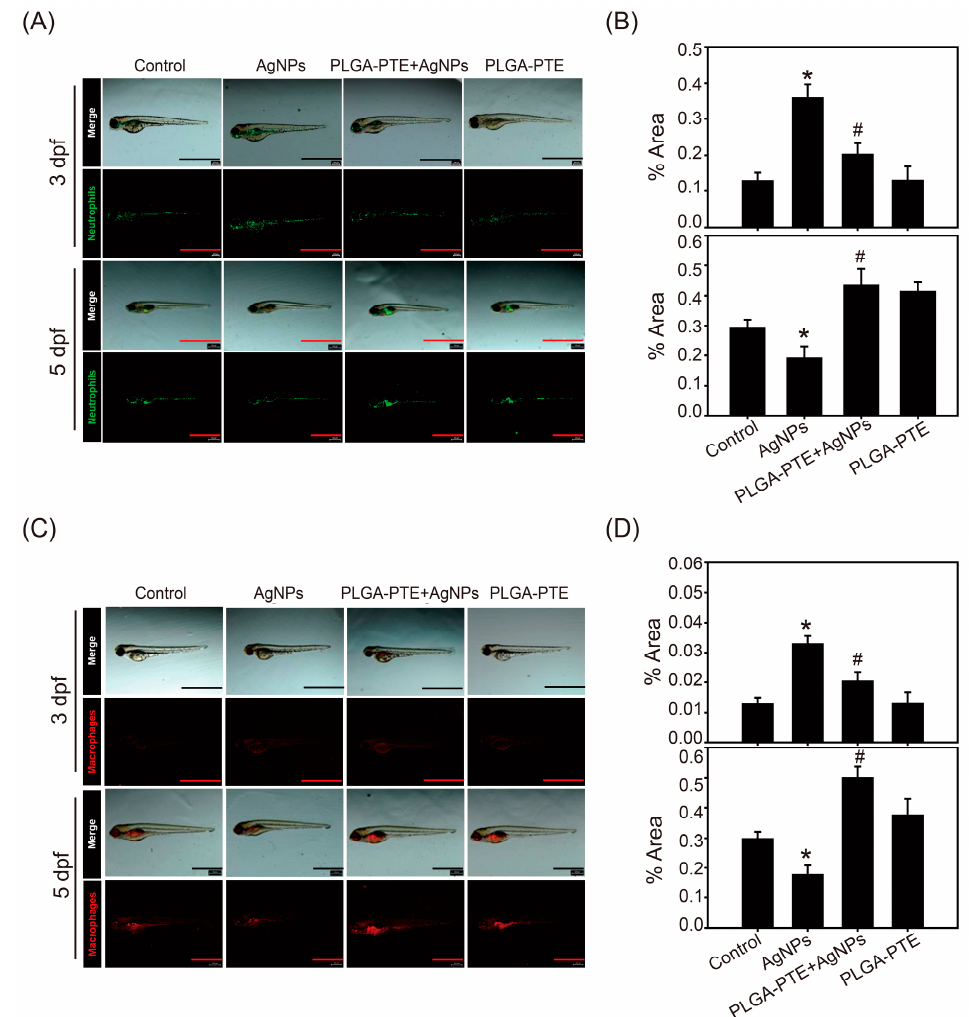
Figure 5. The number and distribution of zebrafish neutrophils and macrophages observed under a stereo fluorescence microscope at 3 dpf and 5 dpf. Zebrafish embryos after exposure to control, 0.3 μ g/mL AgNPs, PLGA-PTE + AgNPs, and 0.3 µ g/mL PLGA-PTE for 3 and 5 dpf. ( A ) The green fluorescence image shows neutrophils and ( C ) macrophages, which are shown by red fluorescence Scale bar=1.0 mm.. The quantification of fluorescence imaging is shown in ( B , D ). The image presented is representative of three independent experiments ( n = 3). * p < 0.05, AgNPs groups versus control groups; # p < 0.05, PLGA-PTE + AgNPs versus AgNPs